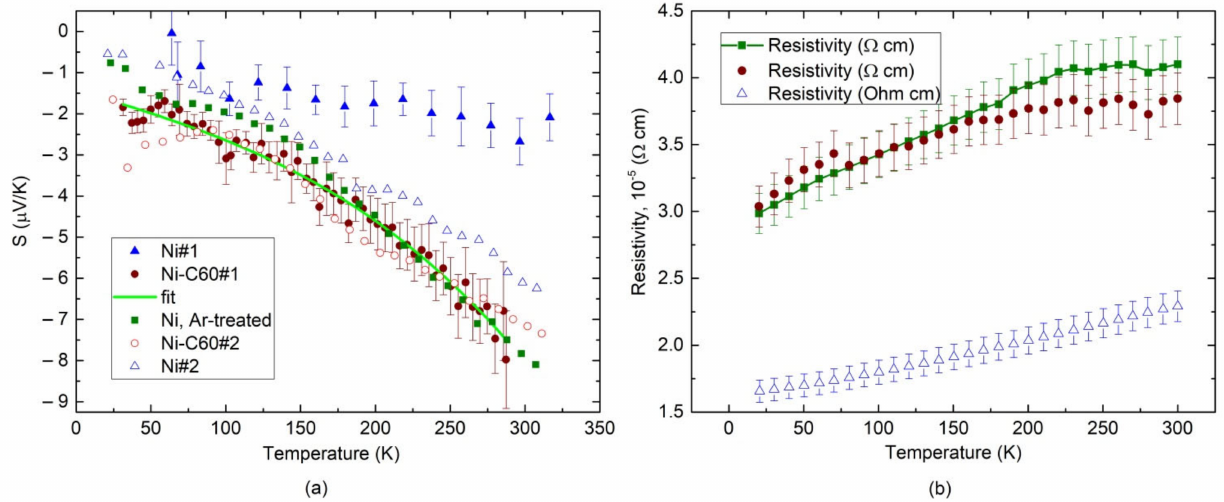
Figure 7. Measured temperature dependence of S Ni − S Cu ( a ) and electrical resistivity; ( b ) in samples Ni (open and closed triangles for two different samples) and Ni-C 60 (open and closed circles for two different samples). Squares represent the data obtained in Ar + –treated Ni film. Line is a fit of the closed circles to Equation